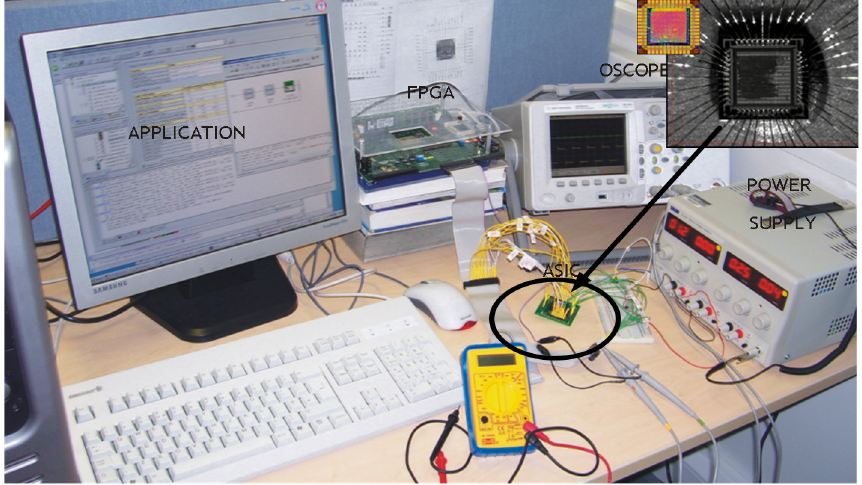
Figure 4. Actual test setup (inset Fabricated ASIC Micrograph).